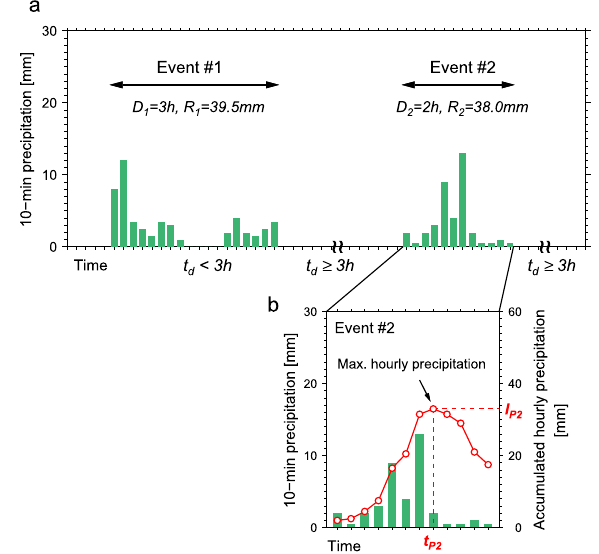
Fig. 1 A schematic illustration for the identi fi cation of indepen- dent precipitation events. a Arti fi cially produced time series of 10 min precipitation. Symbols D, R, and t d indicate event duration, total precipitation accumulation, and dry (non-precipitation) dura- tion, respectively. b Time series of 10 min precipitation (left axis, green bars) and accumulated hourly precipitation calculated every 10 min (right axis, circles) for Event #2. Symbols I p and t p indicate event peak hourly precipitation and peak time, respectively. The scale of the x -axis has an interval of 10 min for both